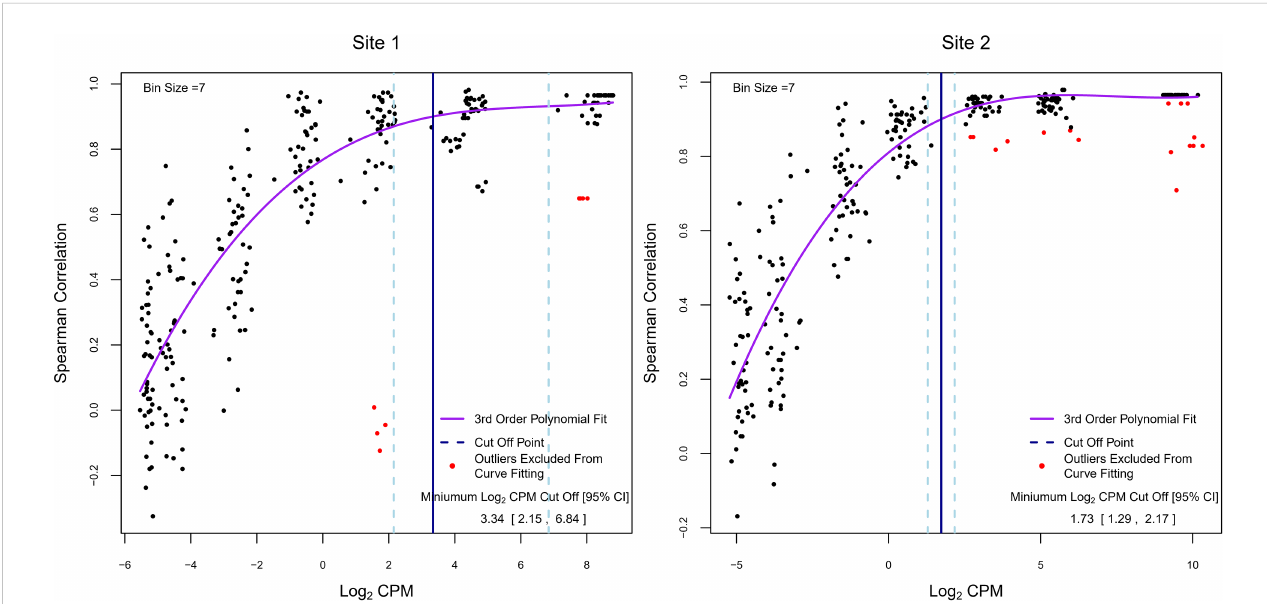
FIGURE 6 Determination of empirical minimum expression cutoffs using ERCC spike-ins. Each dot represents a subset of the 92 ERCC1 and ERCC2 transcripts for one paired sample grouped by average ERCC1 and ERCC2 abundance (on average 13 per abundance bin). The y-axis summarizes the Spearman correlation between the empirical log 2 fold change and expected log 2 fold change across these transcripts. The x-axis represents the average log 2 abundance per paired sample for a subset of the ERCCs. Overall, 40 pre- and post-treatment pairs were created for each experiment. Each pair is shown multiple times (once in each abundance bin). The purple line represents the fi tted 3 rd order polynomial function. Red dots represent paired samples with outlying correlation results relative to their abundance bin (exceeding ±1.5 times the interquartile range) which were excluded from curve fi tted curve is equal to a correlation value of 0.9, and the fi tting. The vertical blue solid line indicates the log 2 counts per million value at which the vertical light-blue dashed lines show the 95% bootstrap con fi dence interval for this log 2 counts per million value. The values in the lower right correspond to these vertical lines: the point estimate and 95% bootstrap con fi dence interval of the log 2 counts per million at which the fi tted polynomial was equal to